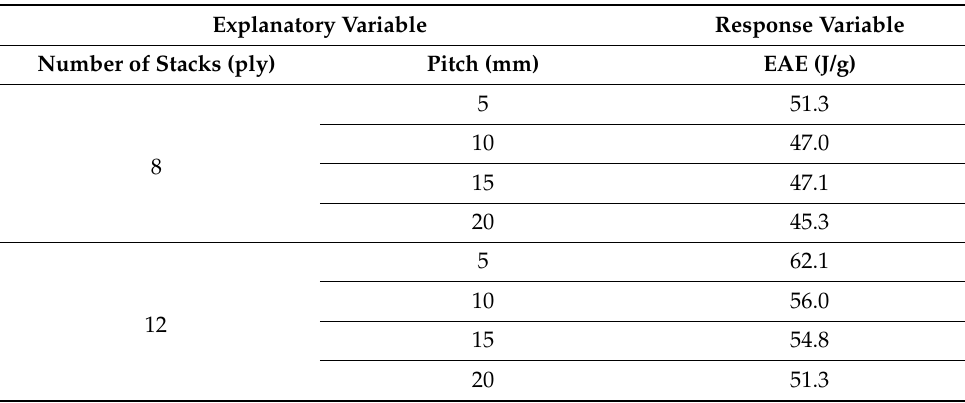
Figure 16. EAE–pitch curves. Multiple regression analysis was conducted, with the number of stacks and pitch serving as explanatory variables and EAE as a response variable. Table 3 shows the explanatory variables and response variable. Table 3. Explanatory variable and response variable (EAE).